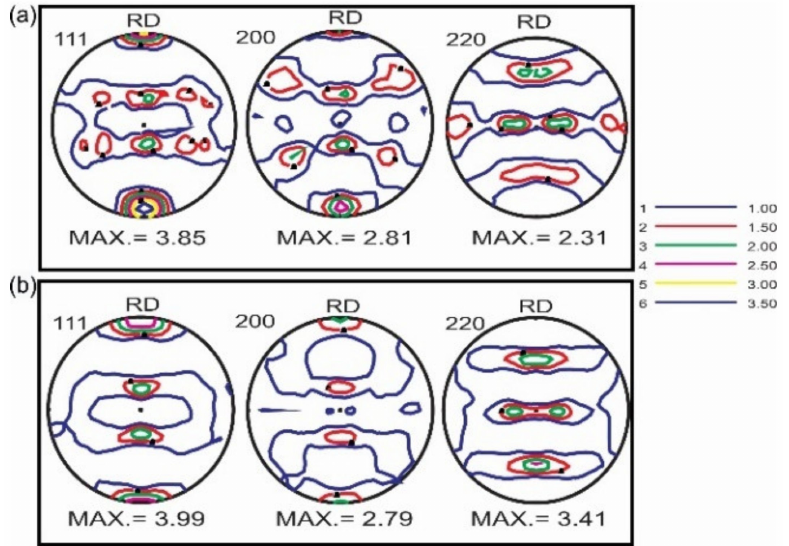
Figure 6. { 111 } , { 200 } and { 220 } PFs at the ( a ) max and ( b ) min positions of the drawn tube using − 5 ◦ tilting angle.